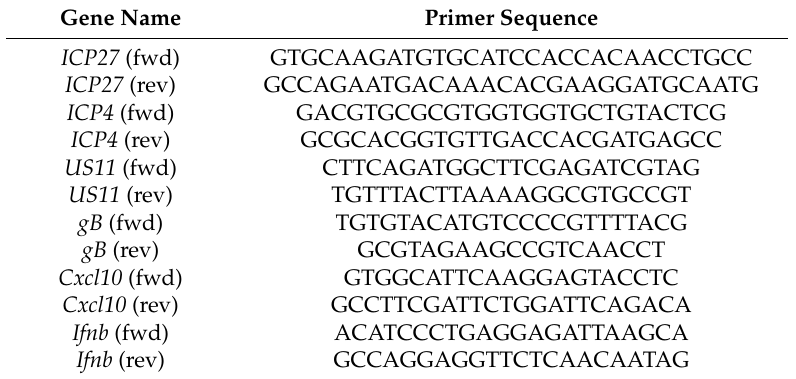
Table 1. Primer sequences used for quantitative real time-polymerase chain reaction